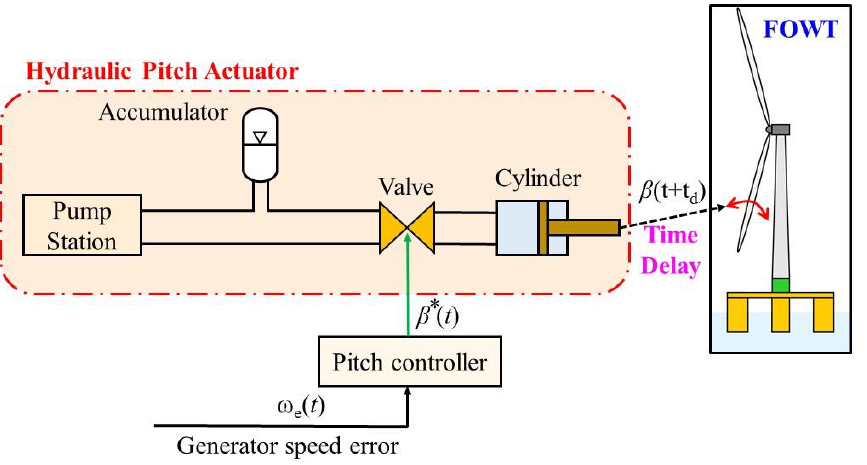
Figure 4. Configuration of pitch controller based on hydraulic actuator.